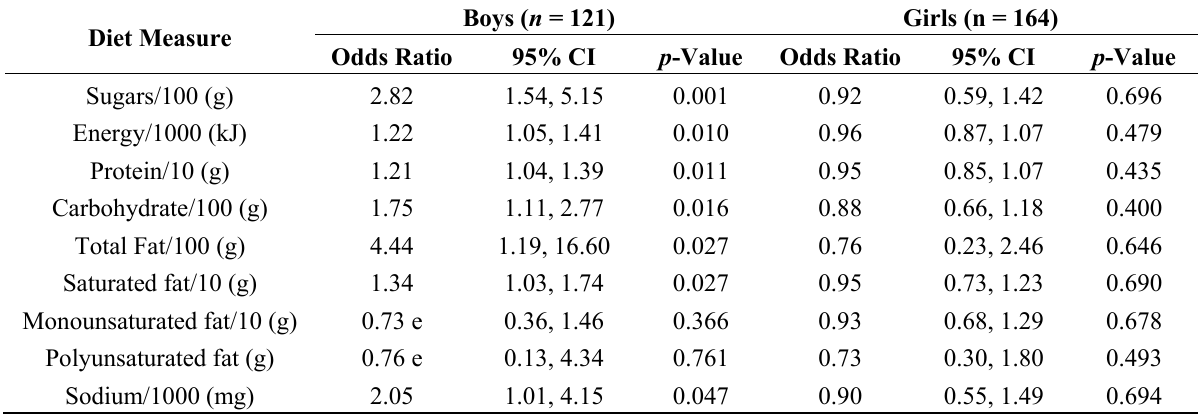
Table 6. Odds ratios, 95% confidence intervals (CI) and p -values from multivariate logistic regression models of CVD risk score on individual diet measures and total energy (e indicates total energy was significant in the model at the 5% level).